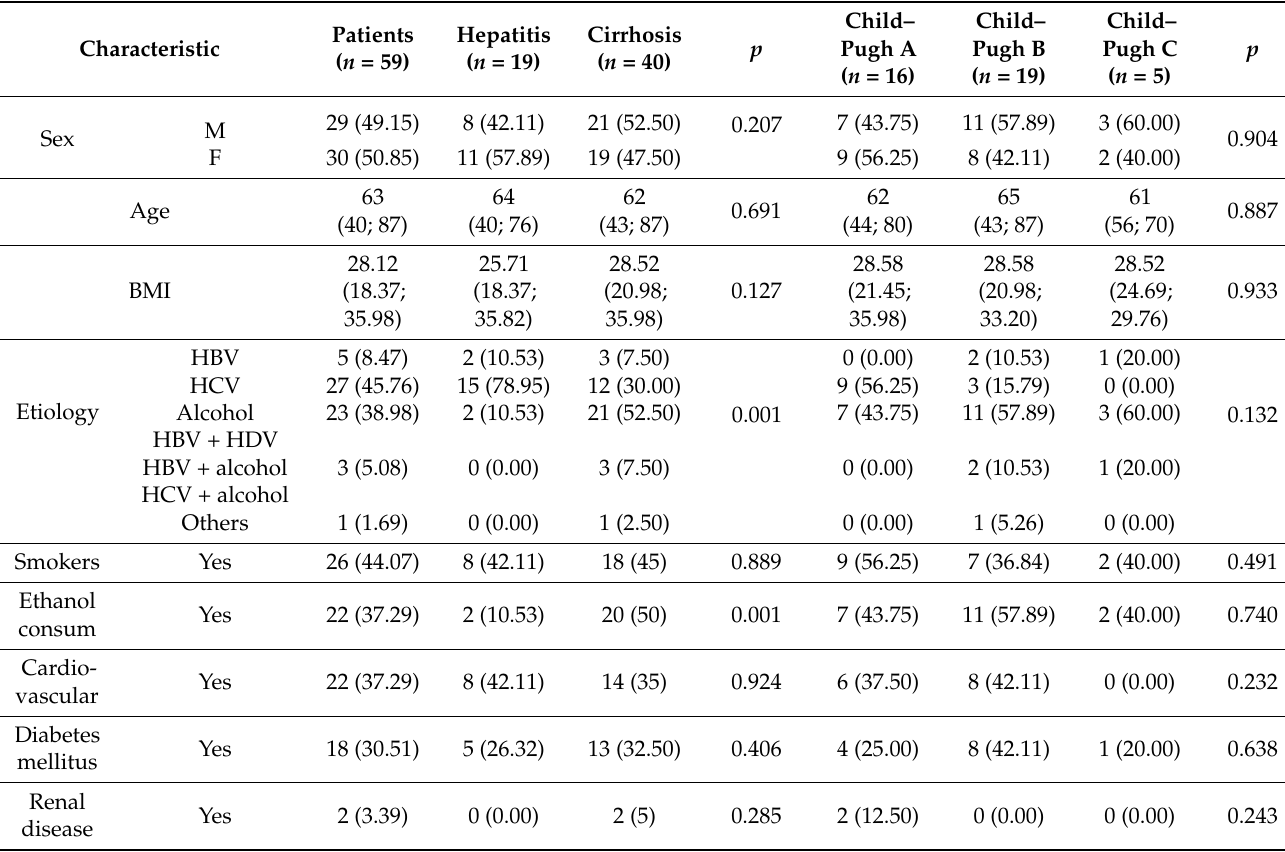
Table 1. Demographic characteristics and laboratory